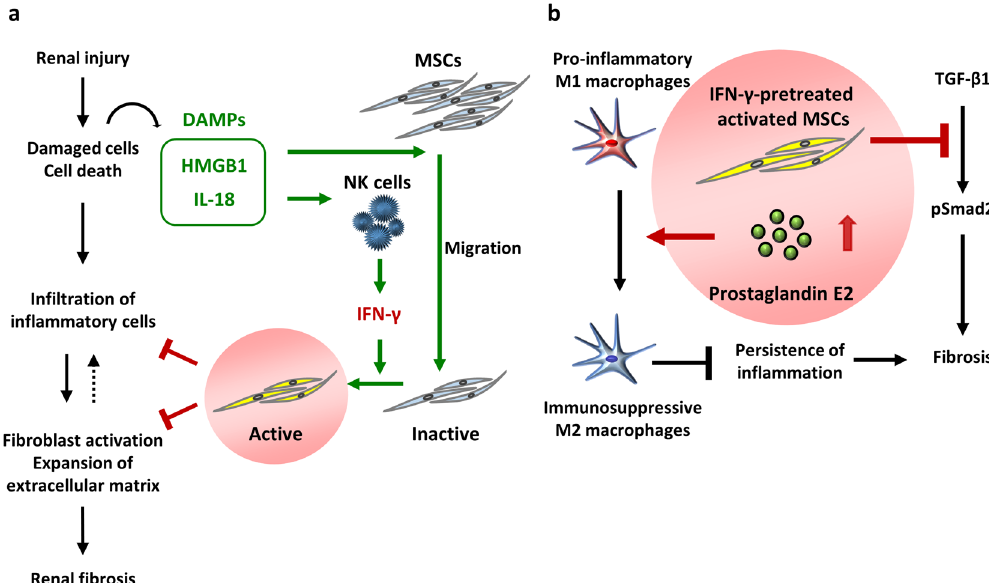
Figure 8. DAMPs and the effects of MSCs treated with IFN-γ on renal fibrosis. ( a ) HMGB1 and IL-18 are members of DAMPs—HMGB1 was reported to promote the migration of MSCs, whereas IL-18